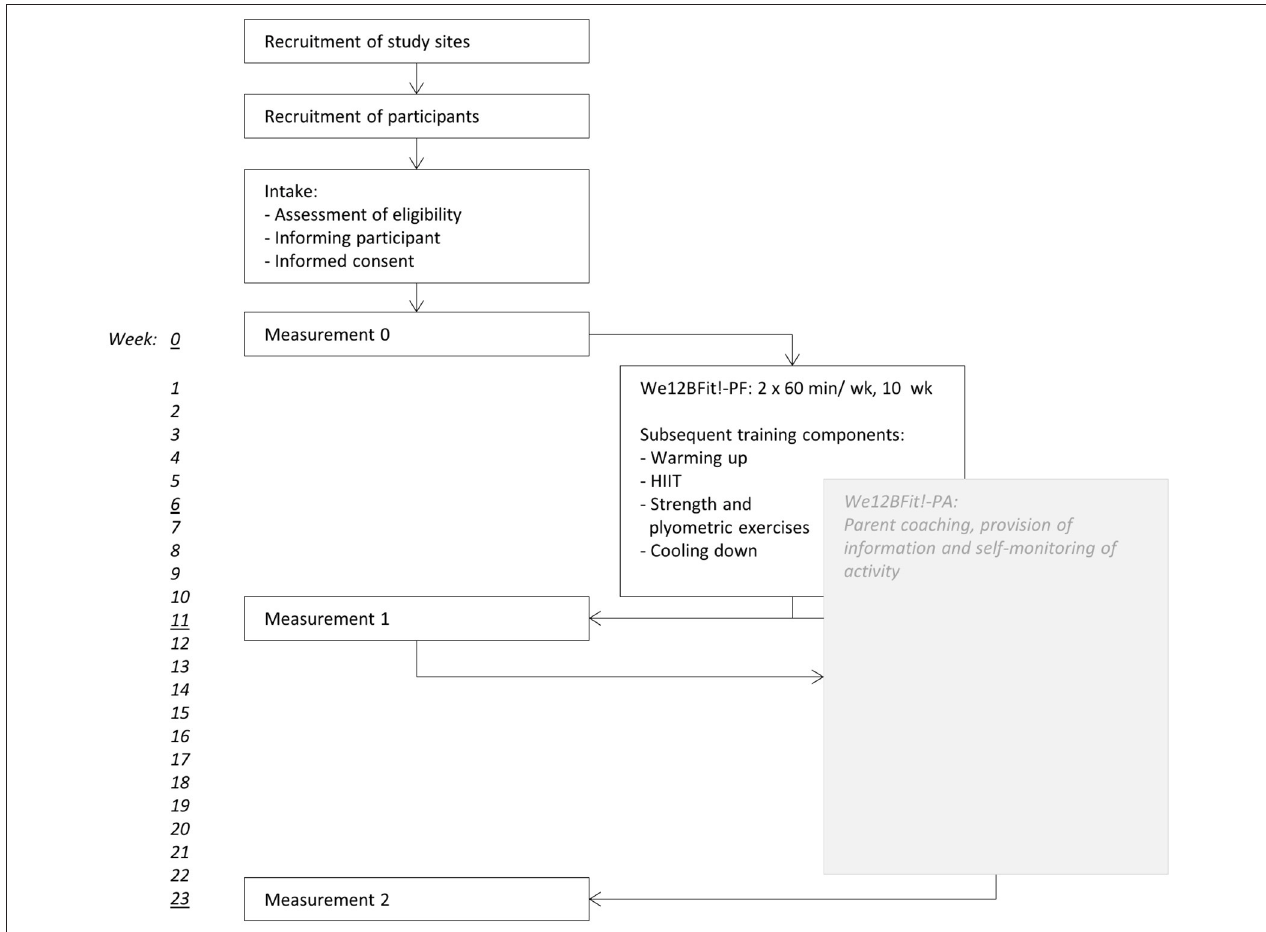
FIGURE 1 | Stepwise procedure of We12BFit! and its evaluation.